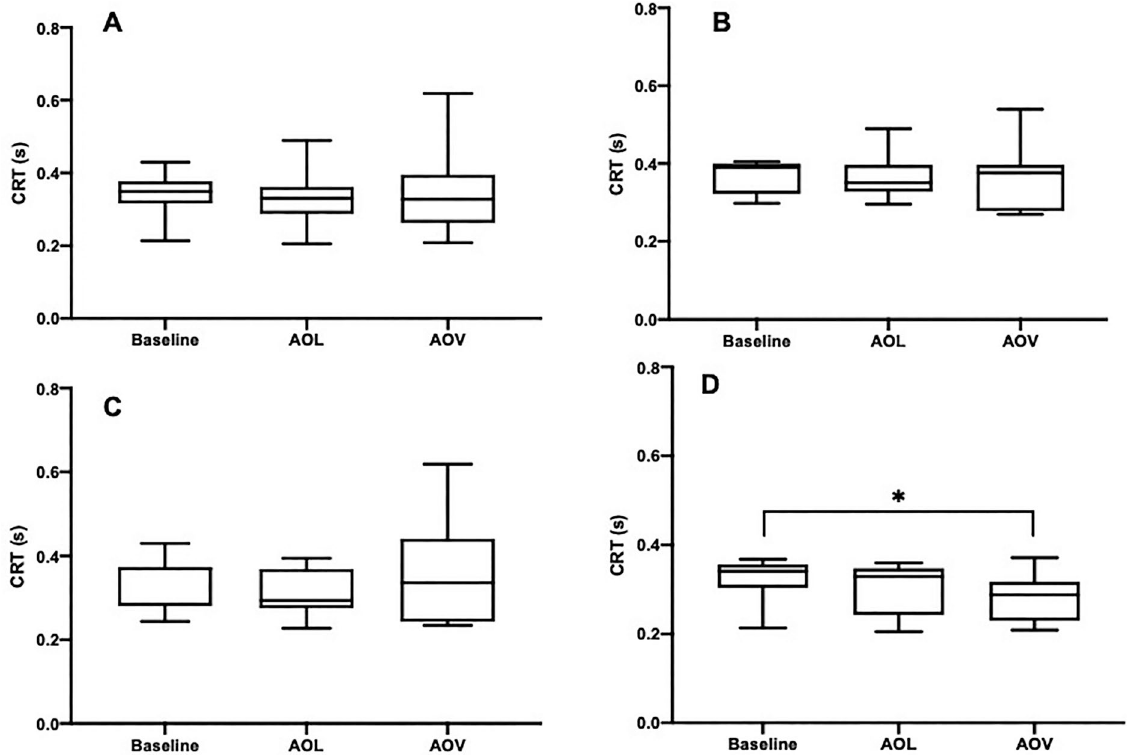
Figure 3 - Choice reaction time before and after AO intervention (in live and in the video); A: all children; B: 6 years old; C: 7 years old; D: 8